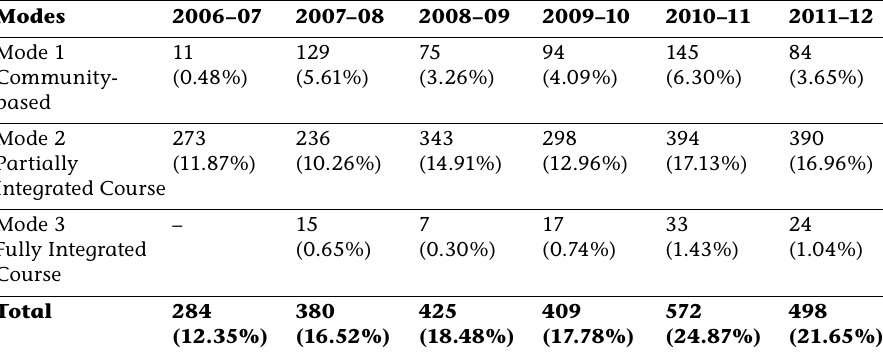
Table 1: Number of LU students joining different S-L modes,